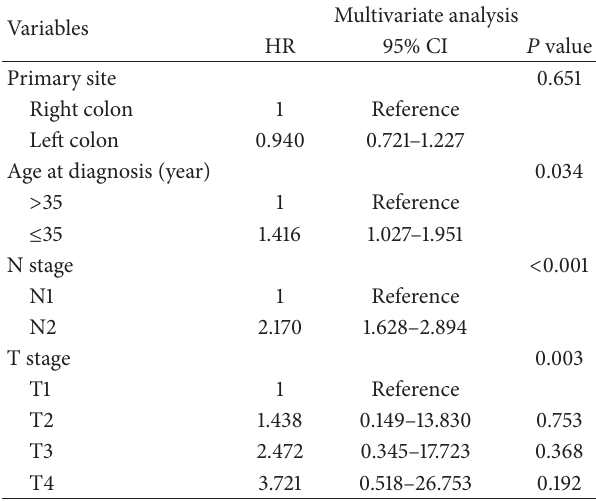
Table 4: Multivariate survival analyses of determinants of cancer- specific survival (CSS) of patients with stage III signet-ring cell carcinoma of the